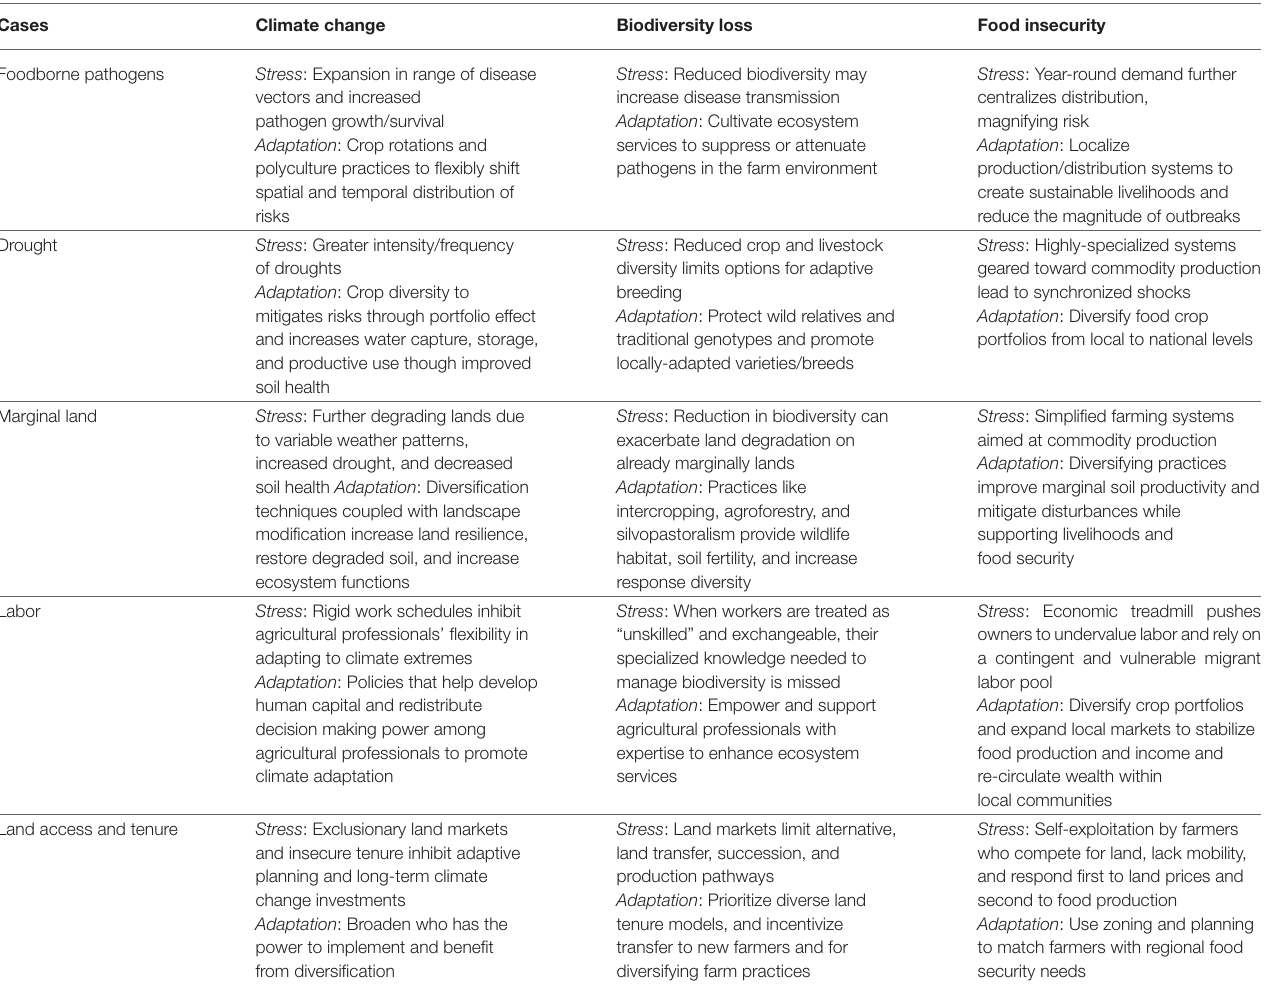
TABLE 1 | Increased stresses from, and potential diversifying adaptations to, the triple threat for each of the five cases.